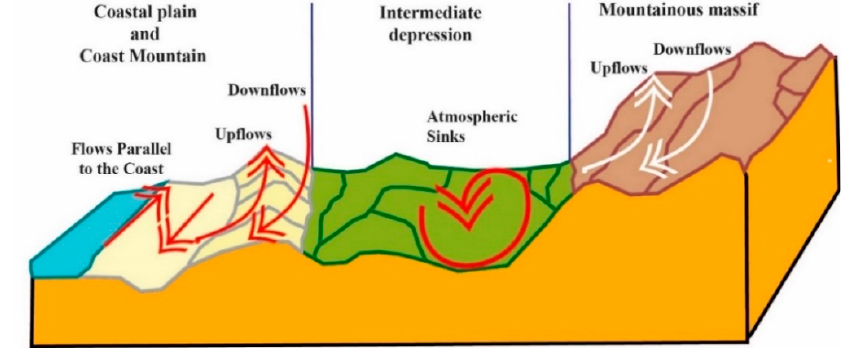
Figure 5. Human settlements according to geographic profile and wind dynamics.